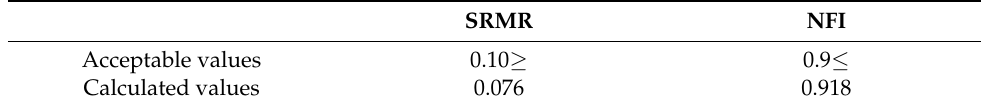
Table 3. SRMR and NFI (Source: authors).